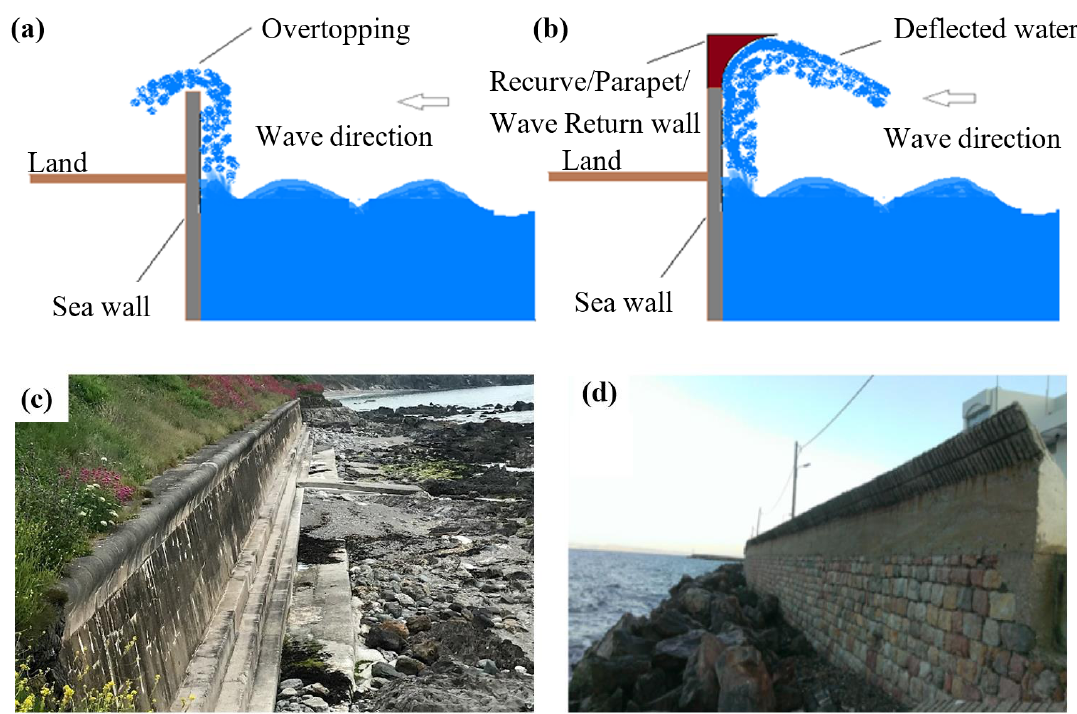
Figure 1. Schematic of the operation principle of a seawall equipped with a recurve, ( a , b ) and photographs of a seawall equipped with a recurve ( c ) and a chamfered parapet ( d ).